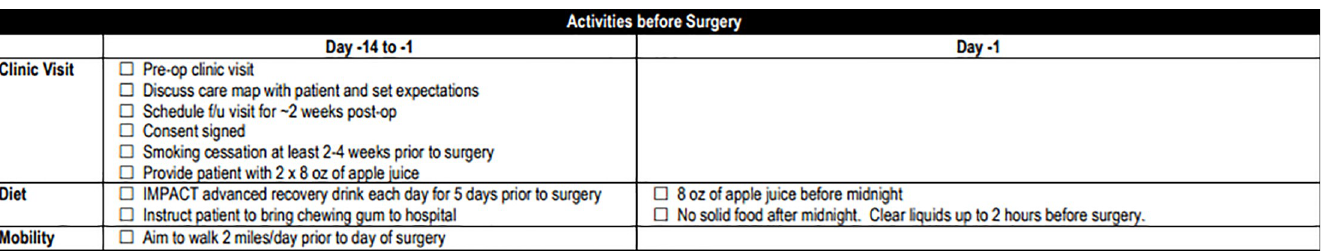
anticoagulation with subcutaneous heparin is instituted preoperatively on the day of surgery